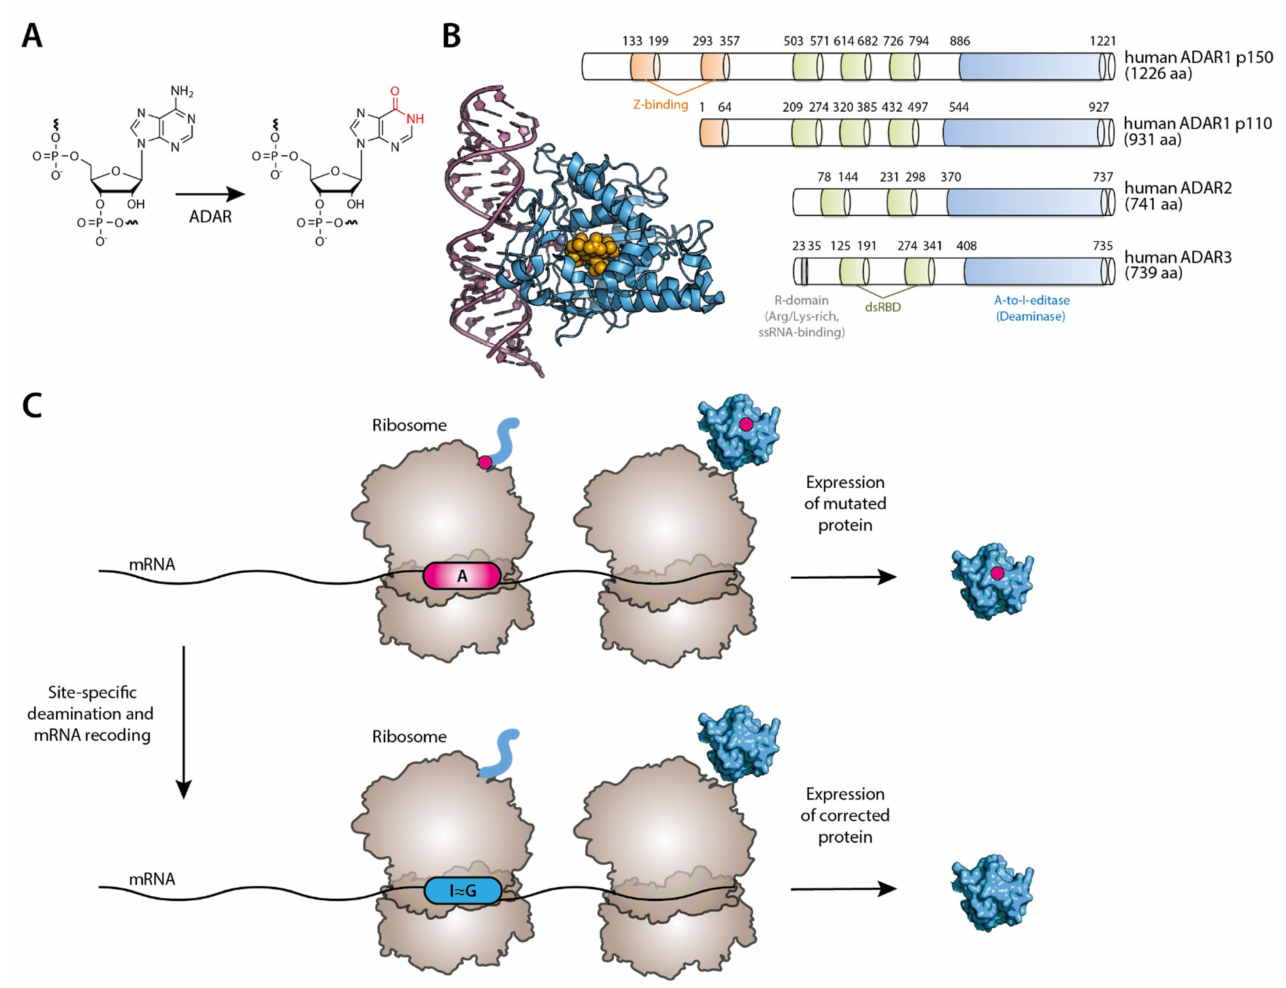
Figure 5. ( A ) ADAR-mediated RNA modification mechanism of deamination from adenosine to inosine. ( B ) Crystal structure of an RNA-bound ADAR fragment (PDB: 5ED1 [18]) and domain organization of human ADAR proteins. ( C ) Since inosine has a base-pairing behavior similar to guanosine, it is decoded as such by the ribosome. This allows for the correction of G-to-A point mutations to be reversed by site-specific deamination of target